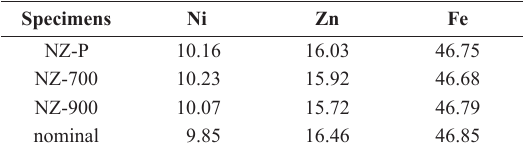
Table 1. The nominal and real content of metal elements detected by XRF in different specimens.